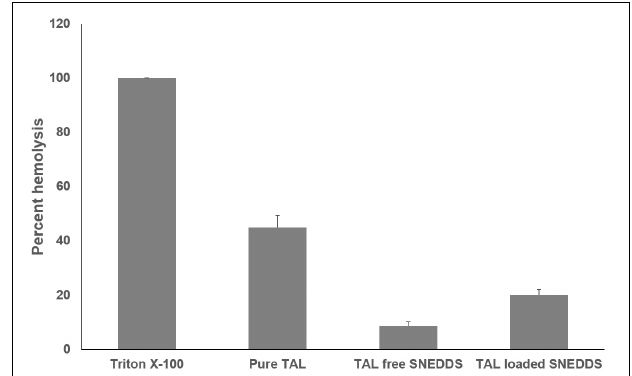
FIGURE 9 | In vitro toxicity test of pure TAL, Blank SNEDDS (drug free), and TAL loaded SNEDDS on blood erythrocytes. The extent of damage caused to blood erthyrocytes by TAL was measured as percentage lysis of total (RBC) red blood cells added. The data is a mean ± SD of three set of different experiments. Formulation represents F6 SNEDDS [I308:TC(1:1)/HCO30(1/1)].